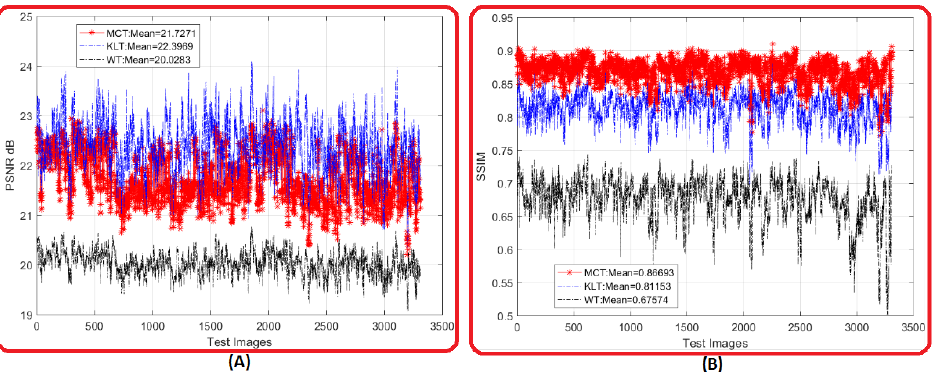
Figure 15. A metric comparative evaluation applied on 3315 facial images of full face dataset of AR database. ( A ) PSNR and ( B )